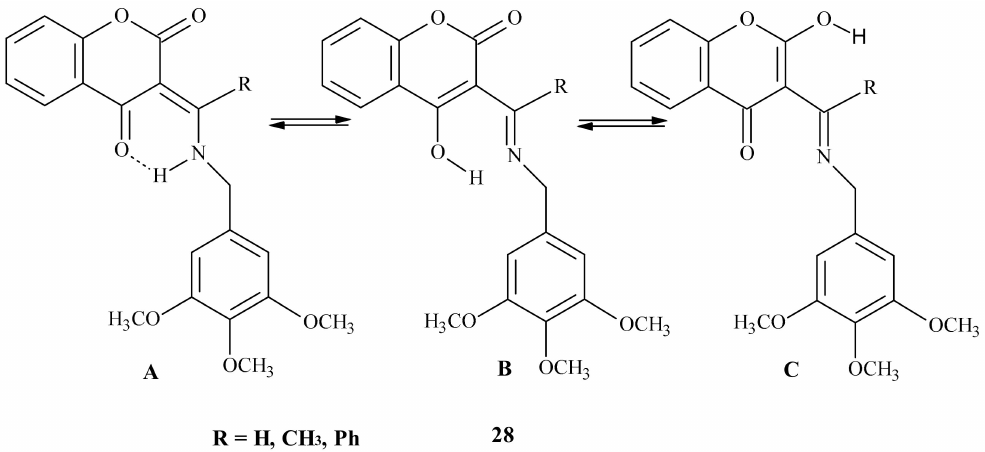
Scheme 9. Possible tautomeric forms of 28 bearing the 3,4,5-trimethoxybenzylamine ( 28A ) or 3,4,5-trimethoxybenzylimine moiety ( 28B and 28C ).